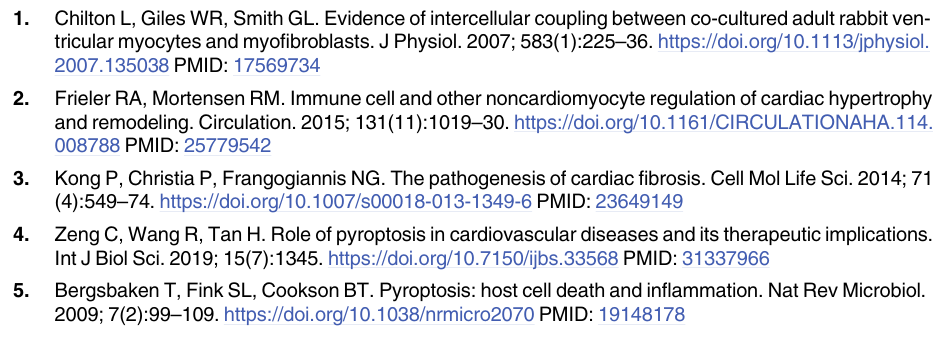
S1 Table. Hemodynamic variables. S2 Table. OD values of CK, LDH, and IL-1 β . S3 Table. Western blot analysis. S4 Table. ROS fluorescence